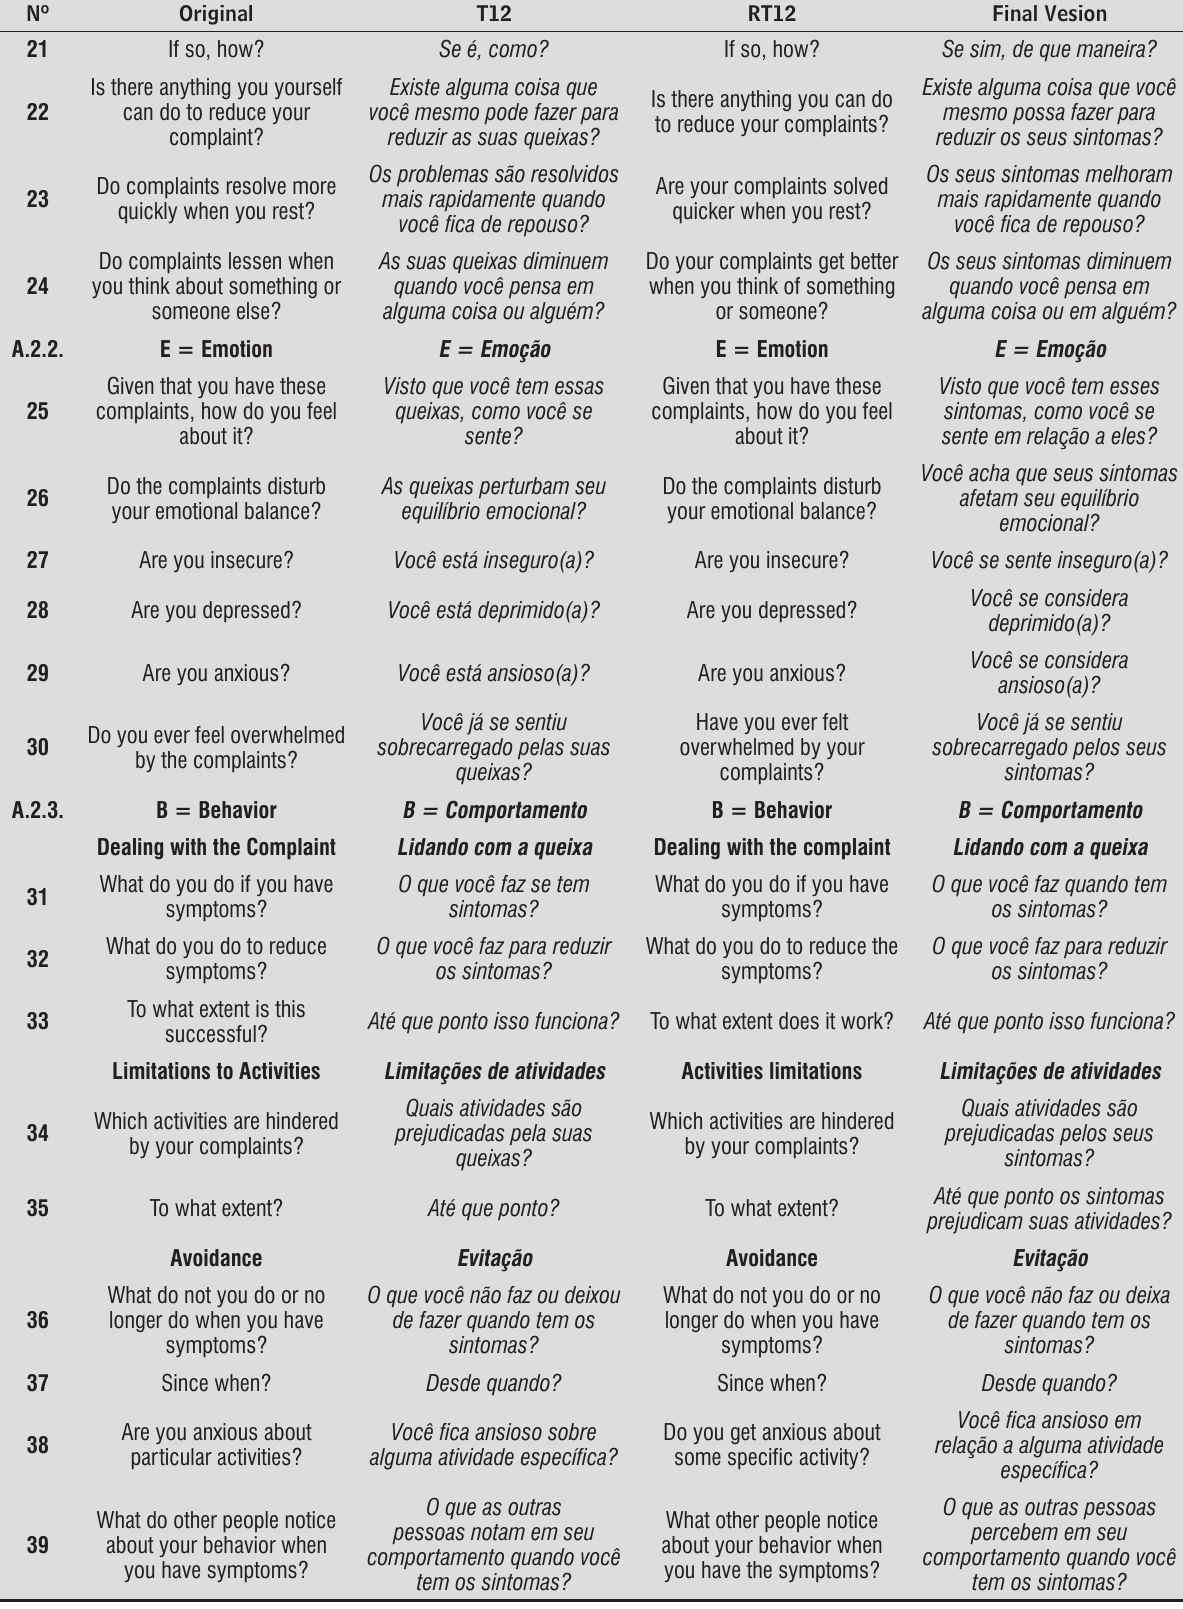
Table 1 - The transcultural adaptation of the SCEBS method